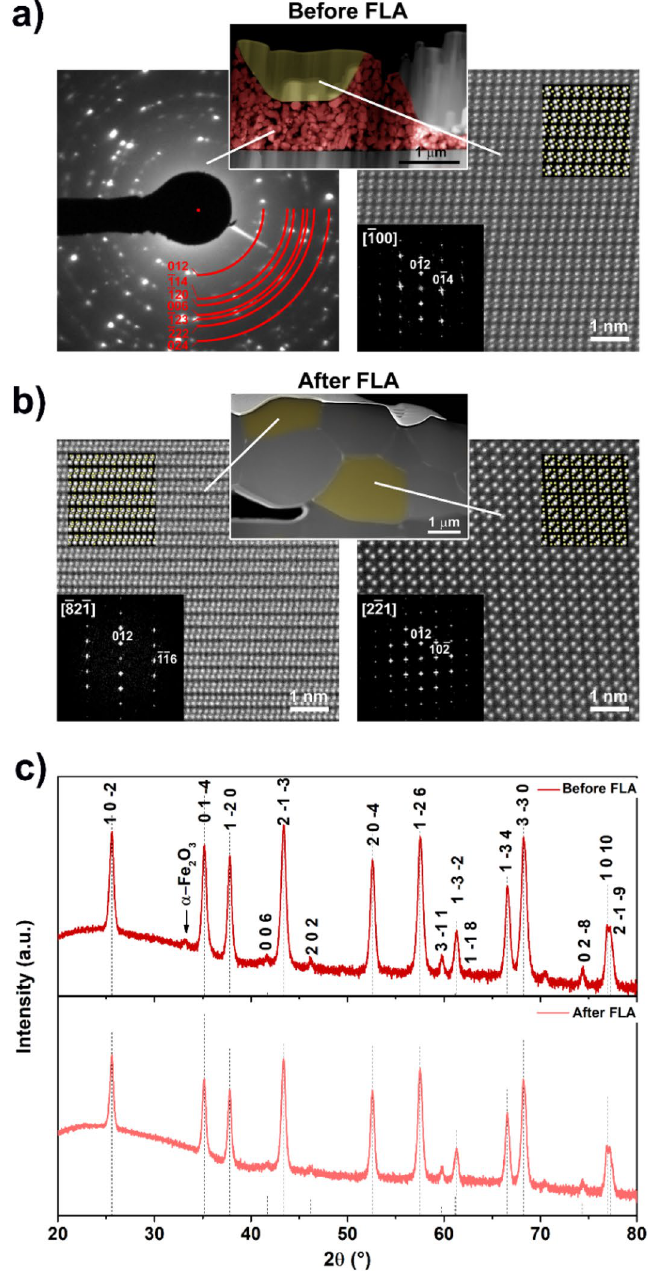
Figure 4. Structural characterization of the ceramic film before and after the FLA process. ( a ) Ceramic film before FLA: electron diffraction pattern and high-resolution HAADF-STEM image acquired from the nm-sized α-Al 2 O 3 and α-Fel 2 O 3 particles (indicated in red in the low-magnification HAADF-STEM image) and the µm-sized α-Al 2 O 3 particle (shown in yellow), respectively. ( b ) Ceramic film after FLA: HAADF-STEM images acquired from the µm-sized α-Al 2 O 3 particles highlighted in yellow. The electron diffraction pattern and the Fourier transforms of the HAADF-STEM images are all indexed using the α-phase of Al 2 O 3 . Models of the α-phase of Al 2 O 3 along the corresponding zone axis are shown as insets; the Al and O atoms are shown in white and yellow, respectively. ( c ) XRD patterns of the ceramic films before and after